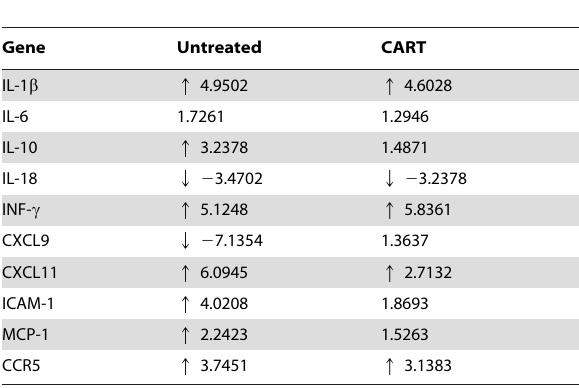
Table 4. Cytokine expression